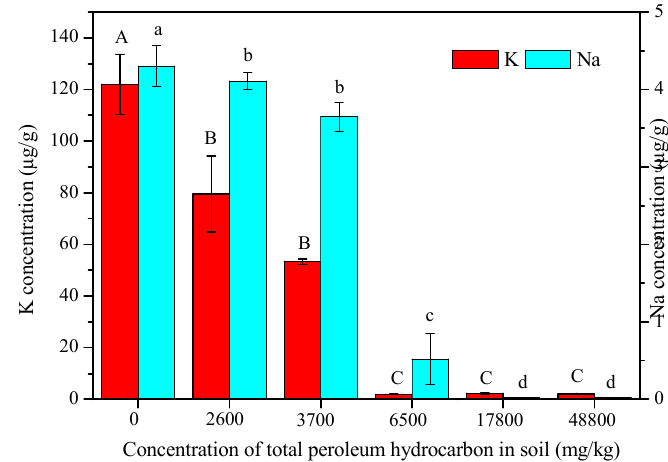
Figure 4. Effect of soil contamination with crude oil on K and Na concentrations in maize leaf. ( p < 0.05). Different letters on top of the bar indicate they are significantly different at p < 0.05.